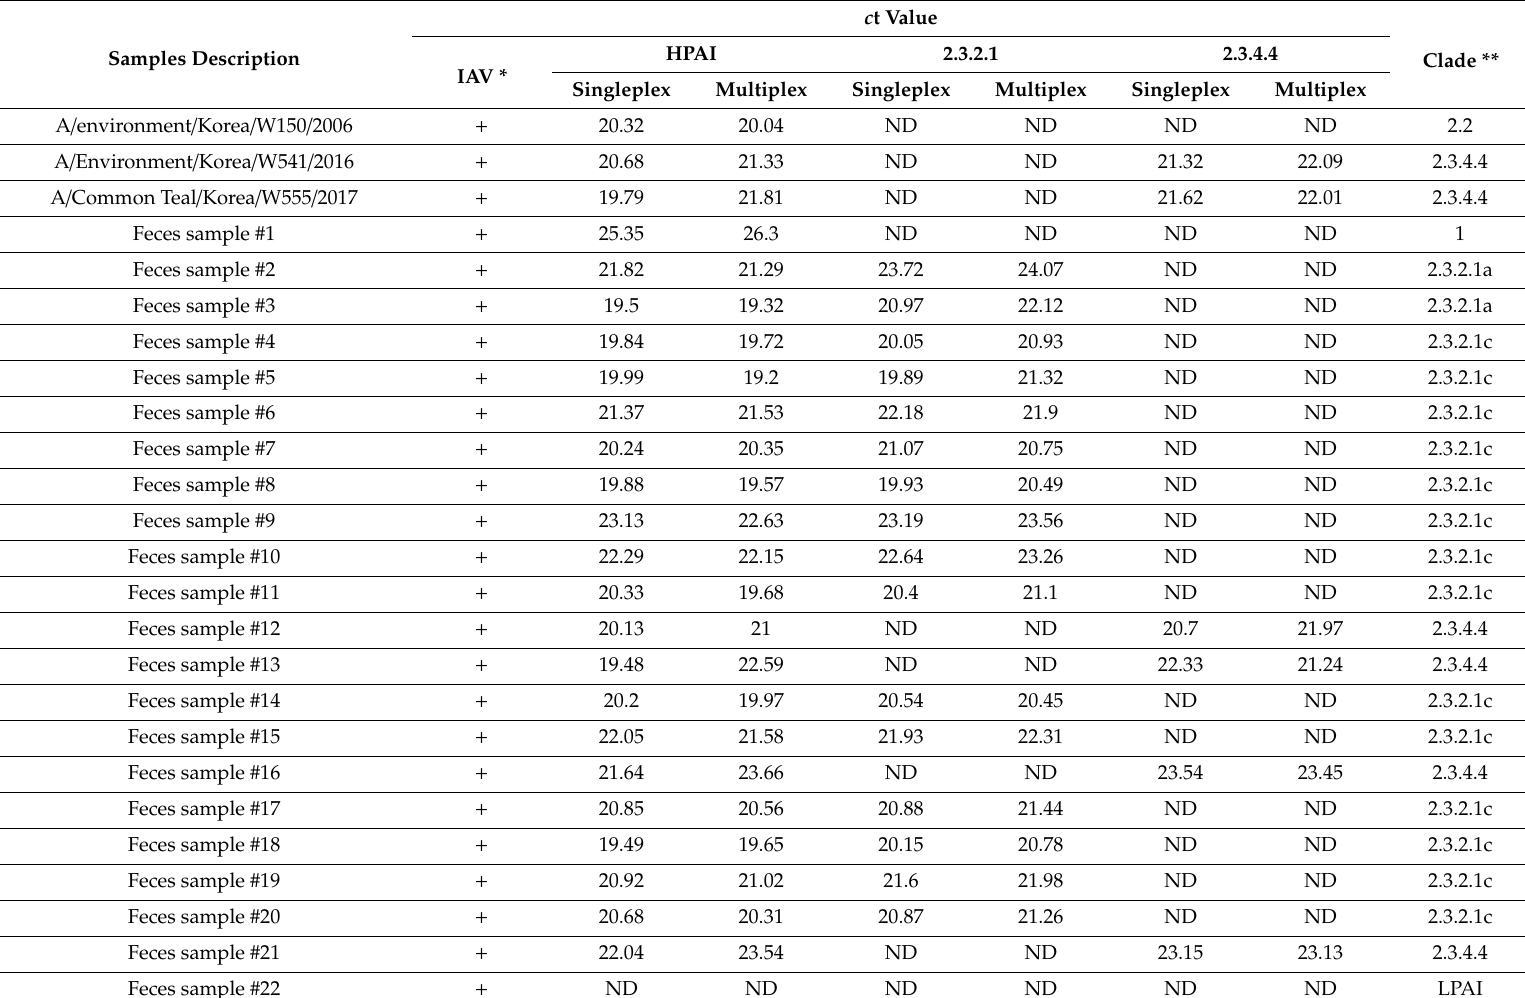
Table 3. Application of the multiplex RT-qPCR to feces samples from field-infected